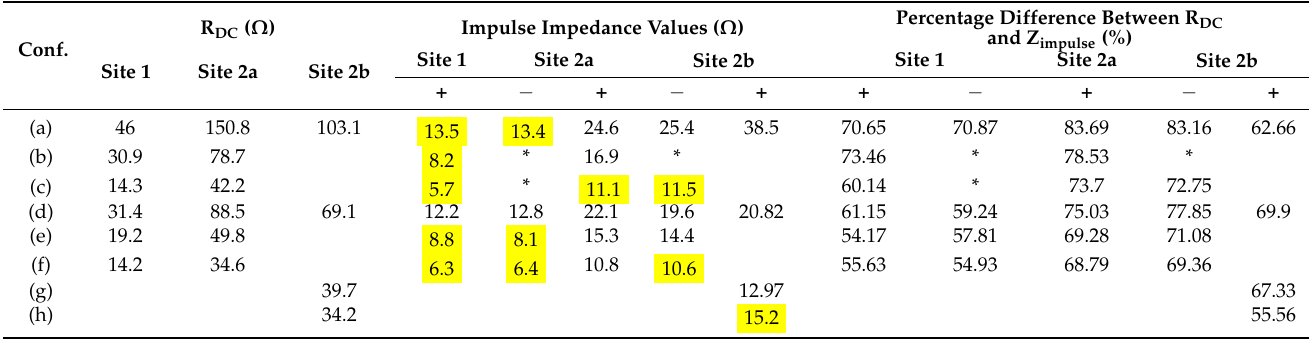
Table 3. R DC , Z imp, and percentage difference between R DC and Z imp